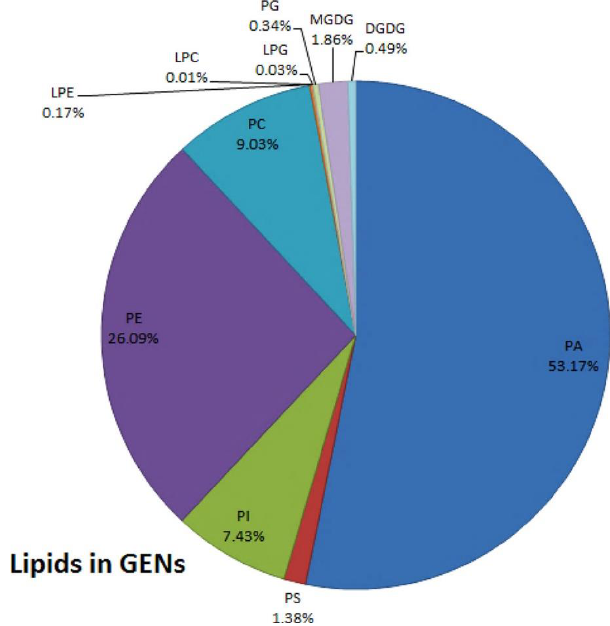
Figure 2. Synopsis of the putative lipid species in grape derived EVs; reported as percent of total grape derived EVs lipids, attained by sucrose gradient ultracentrifugation and differential centrifu- gation: LPC, lyso-phosphatidylcholines; LPE, lyso-phosphatidylethanolamines; LPG, lyso-phos- phatidylglycerol; MGDG, monoglycerol; DGDG, diglycerol; PA, phosphatidic acids; PS, phosphati- dylserine; PI, phosphatidylinositol; PE, phosphatidylethanolamines; PC, phosphatidylcholines; PG, phosphatidylglycerol. Reproduced with permission from ref.